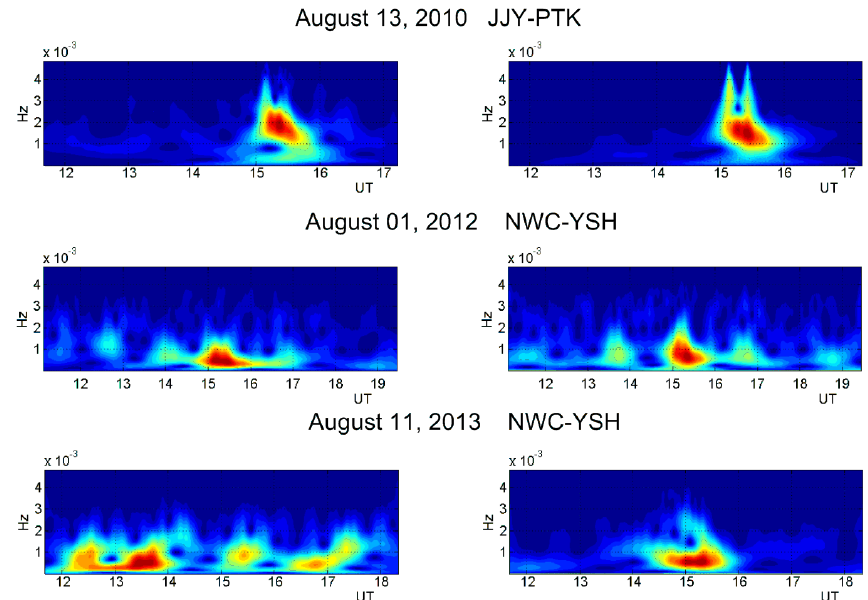
Figure 8. Examples of the wavelet spectra of the filtered (0.2–15mHz) typhoon-induced disturbed amplitudes (left) and phases (right) of the VLF/LF